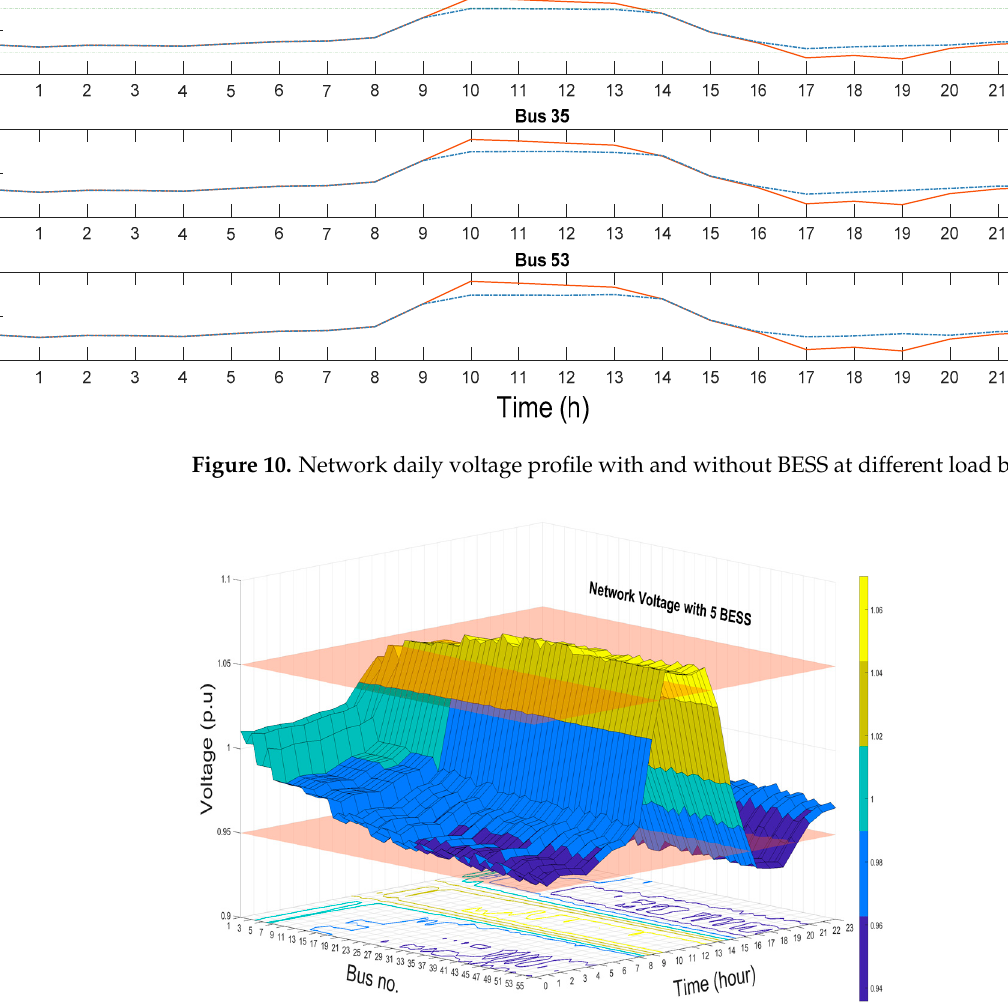
Figure 12. Network voltage profile with 17 BESS installed. Figure 13. Network voltage profile with 21 BESS installed.